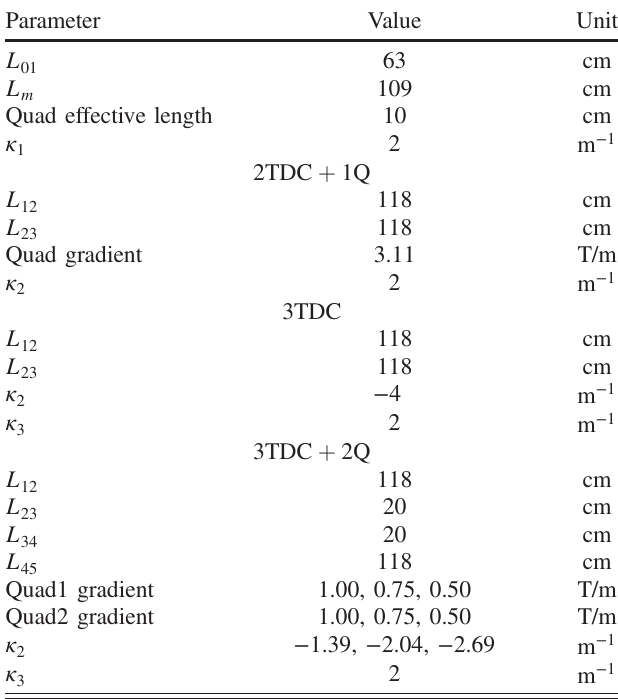
TABLE I. Beam line parameters for each configuration, which are used for Fig. 5 and all simulations in the paper. Lengths are center-to-center